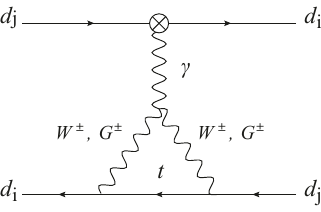
Figure 5 . Feynman diagram for the one-loop contribution to (cid:1) F = 2 operators at the NP